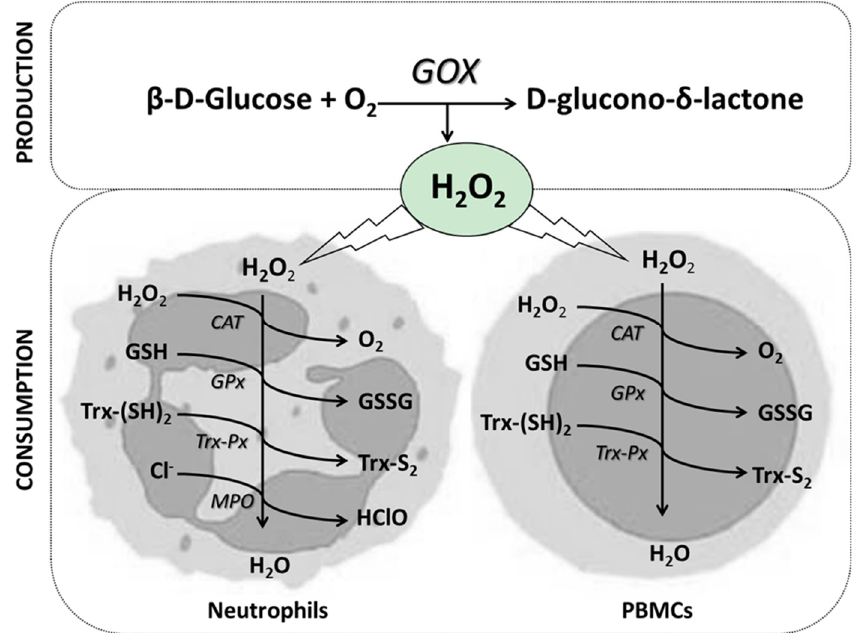
Figure 1. Balance between hydrogen peroxide production and elimination: H 2 O 2 extracellularly produced by glucose oxidase in the presence of glucose can be intracellularly decomposed by numerous antioxidant systems within the immune cells. GOX: Glucose oxidase; CAT: Catalase; GPx: Glutathione peroxidase; TRx-Px: Thioredoxin peroxidase; MPO: Myeloperoxidase; GSH: Reduced glutathione; GSSG: Oxidized glutathione; Trx(SH) 2 : Oxidized thioredoxin; Trx-S 2 : Reduced thioredoxin; Cl − : Chloride anion; HClO: Hypochlorous acid.